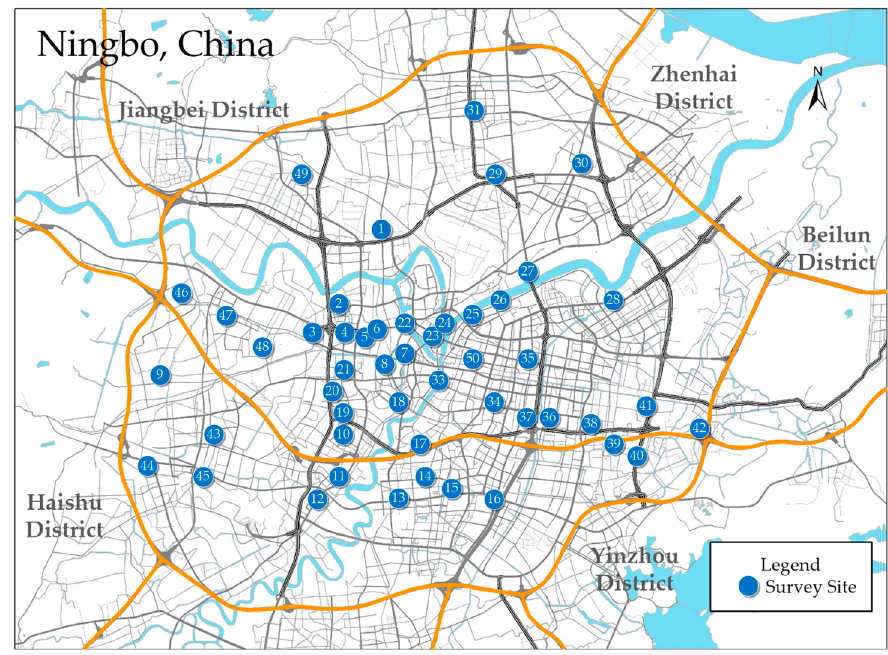
Figure 3. Survey site in Ningbo, China.